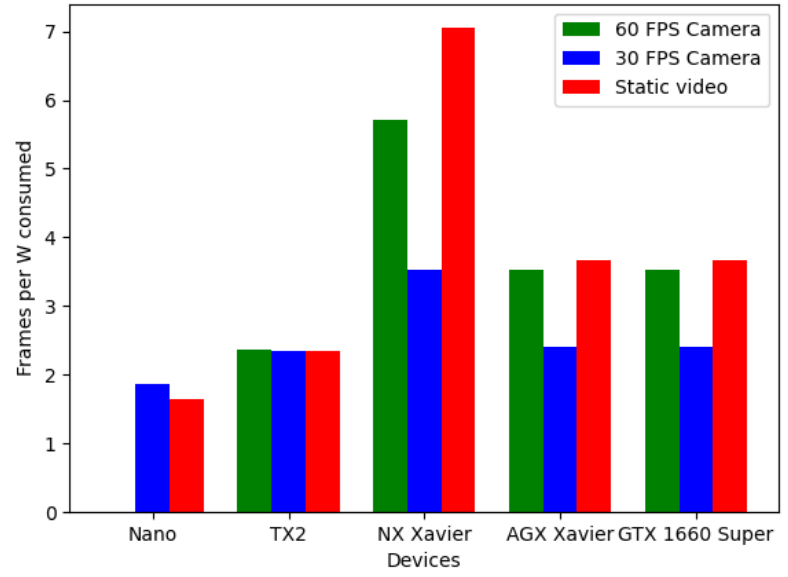
Figure 8. Ratio frame processed per watt consumed for each device and